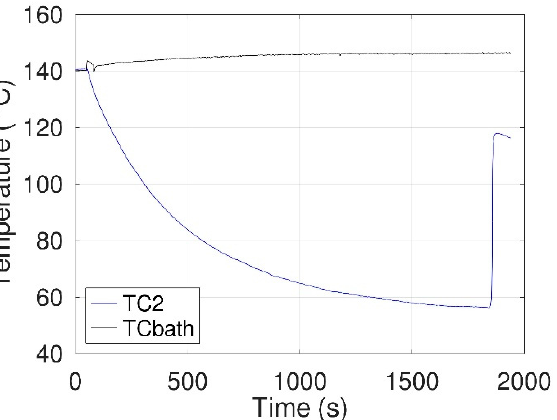
Figure 5. Thermograms (oil bath, TCbath, and erythritol, TC2erythritol, recorded during free cooling without introducing the electrode assembly in the vial.